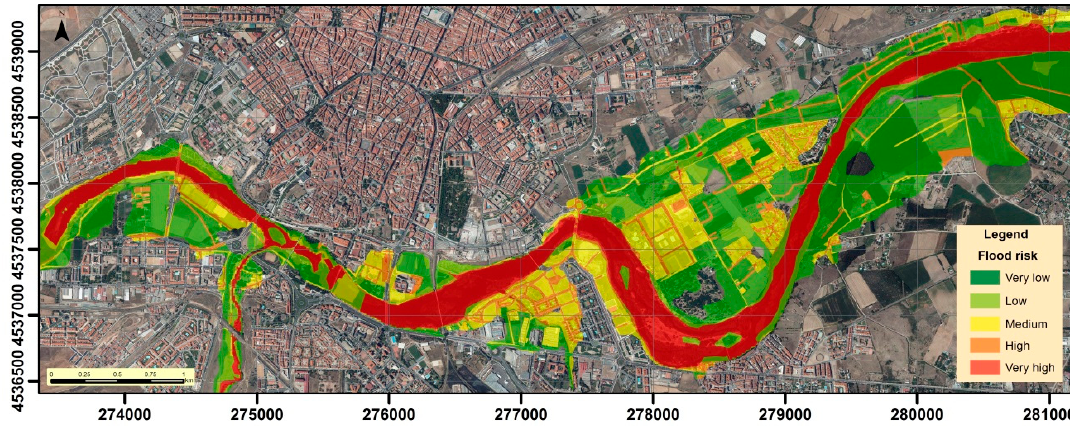
Figure 10. Flood risk estimated in the study area.